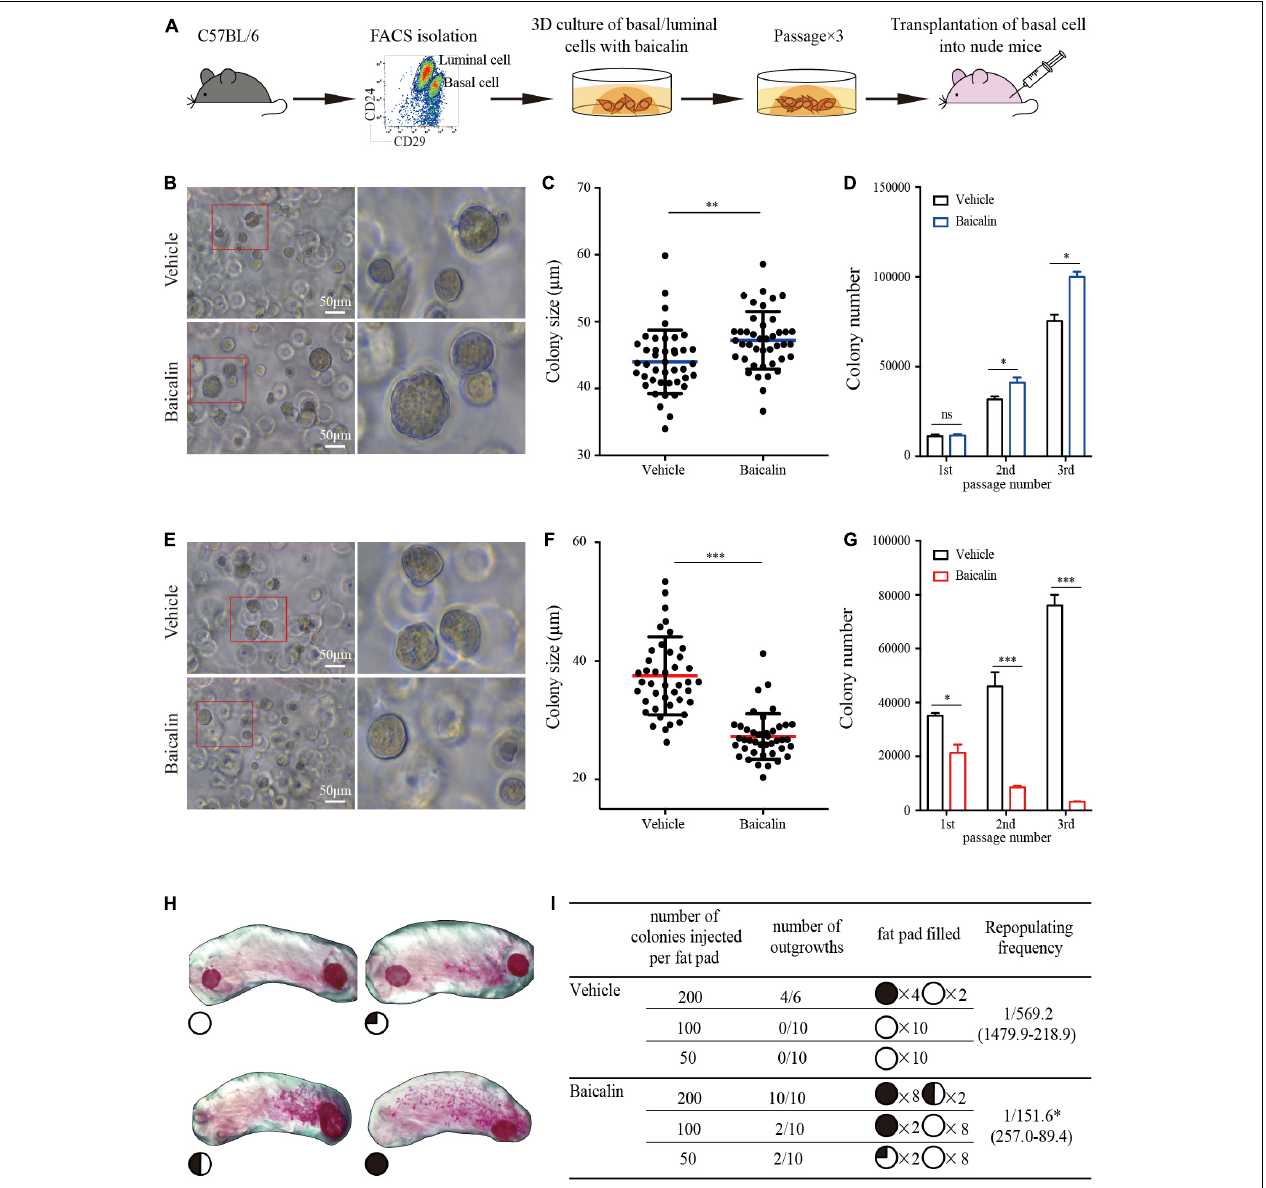
FIGURE 3 | Baicalin promotes the colony formation ability and regeneration capacity of basal cells. (A) Illustration of the use of FACS to obtain basal and luminal cells, 3D culturing of basal and luminal cells under baicalin treatment, and basal cell transplantation assays. (B) The colony formation efficiency of basal cells after treatment with baicalin in Matrigel culture. Scale bar, 50 µ m. The red box indicates the focal structure. The data represent three independent experiments. (C) Colony size of basal cells in Matrigel culture. Student’s t -test: ** P < 0.01. (D) Number of basal cell colonies after three passages. Student’s t -test: * P < 0.05; ns, not significant. (E) The colony formation efficiency of luminal cells after treatment with baicalin in Matrigel culture. Scale bar, 50 µ m. The red box indicates the focal structure. The data represent three independent experiments. (F) Colony size of luminal cells in Matrigel culture. Student’s t -test: *** P < 0.001. (G) Colony number of luminal cells after three passages. Student’s t -test: *** P < 0.001; * P < 0.05. (H) Representative images of fat pads with different percentages of filling. (I) The numbers and sizes (shown as the percentage of fat pad filled) of mammary outgrowths are combined from three independent